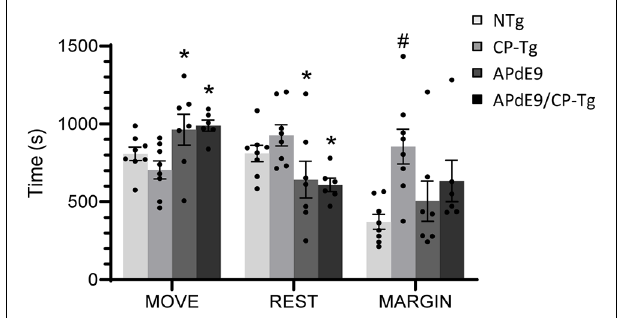
FIGURE 1 | Effects of prostacyclin overexpression in the open-field test in APdE9 and control mice. Increases in ambulation and reduced resting times indicate a reduction in anxiety-like behavior (anxiolytic effect), with the opposite results indicating an increase in anxiety-like behavior (anxiogenic effect). Bars are means ± SEM, n = 7–8 mice per group. * p < 0.05 compared to CP-Tg control mice, # p < 0.05 compared to NTg, APdE9, and APdE9/CP-Tg